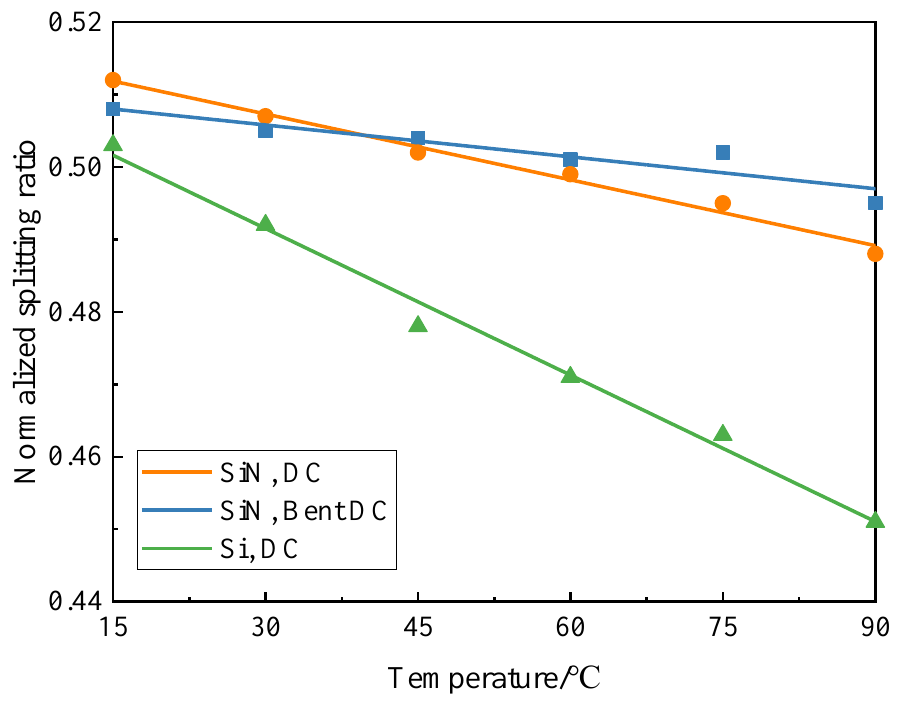
Figure 8. Temperature dependence of splitting ratio (cross port) of the silicon-based conventional DC, silicon nitride conventional DC, and silicon nitride bent DC at the wavelength of 1550 nm. 4. Conclusions A bent DC was designed and fabricated on a 400 nm thick silicon nitride platform. The experimental results suggest that the bent DC obtained a 1 dB bandwidth of 80 nm, which was about twice that of the conventional DC. A fabrication variation of 10% was considered, and the bent DC proved to be fabrication-tolerant in terms of waveguide width and separation in the coupling section. When the temperature changed within 75 15